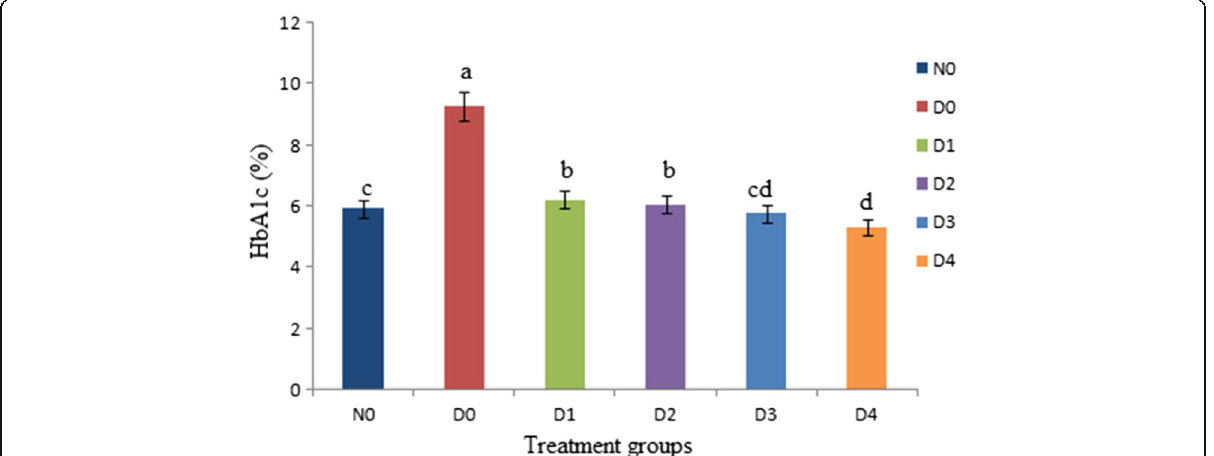
Fig. 3 Effect of Stevia aqueous extract on the glycosylated hemoglobin (HbA1c) level of the rats. Results are expressed as percentage of HbA1c levels of diabetic and non-diabetic rats (mean ± standard deviation (SD). n = 10). a, b, c, d represent significant difference (P < 0.05) in HbA1c levels treatment wise. HbA1c levels of diabetic rats (D 1 , D 2 , D 3 and D 4 ) received stevia aqueous extract in different concentrations (200, 300, 400 and 500 ppm) respectively significantly ( P < 0.05) decreased as compared diabetic (D 0 ) control groups and near to N 0